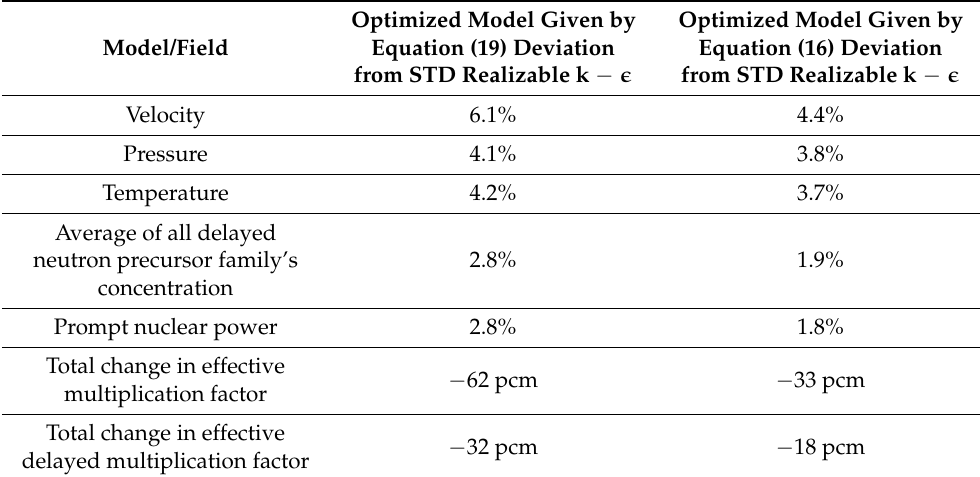
Table 5. Mean-squared relative difference over the computational domain for the coupled fields in the Molten Salt Fast Reactor and total change in the effective neutronics parameters using the structurally optimized turbulence models proposed in Equations (16) and (19) vs. a standard k − (cid:101) realizable model [45]. Optimized Model Given by Optimized Model Given Model/Field Equation (19) Deviation from STD Realizable k − (cid:15)